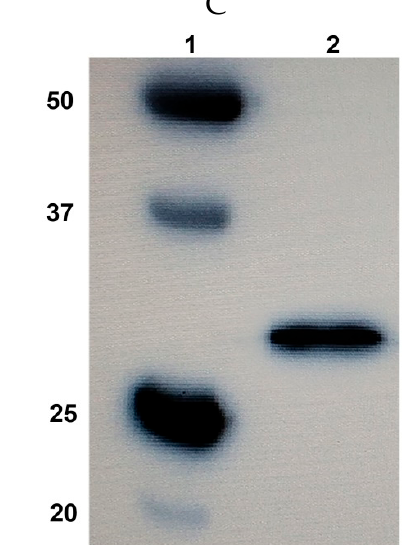
Figure 1. Design and expression of the scFv fragment 14.18. ( A ) Structure of the scFv fragment 14.18. ( B ) 12% reducing sodium dodecyl sulfate polyacrylamide gel electrophoresis (SDS-PAGE); 1, molecular weight protein markers; 2, scFv fragment 14.18. ( C ) Western blot analysis; the membrane was incubated with HRP-labelled anti-FLAG antibodies (1:6000). Visualization with 1-Step Ultra TMB-Blotting Solution.